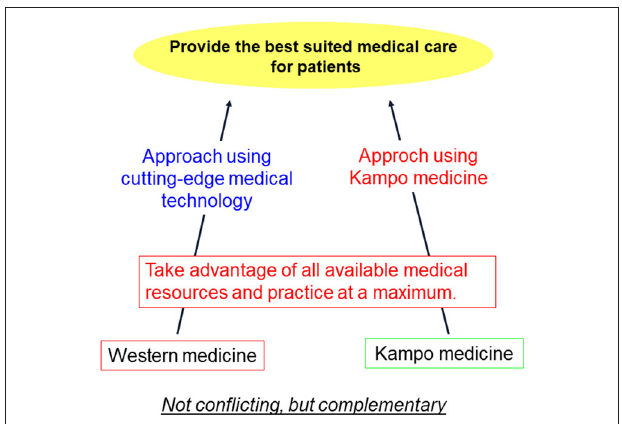
FIGURE 1 | Hybrid-type treatment using Western and Kampo